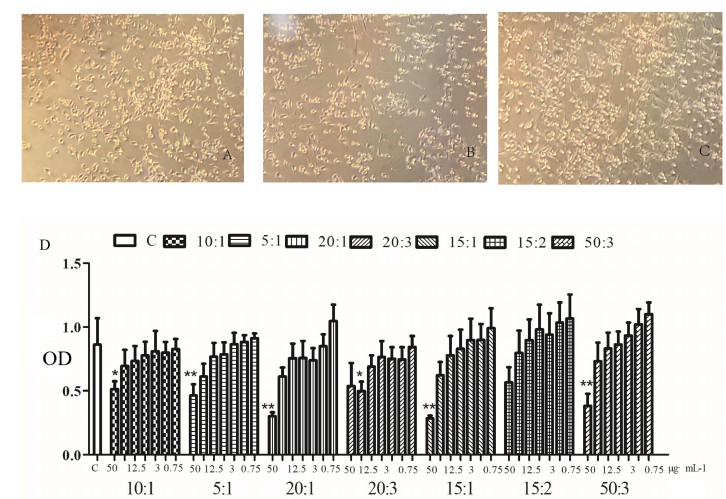
Figure 1. Cell morphology of Normal control group ( A ), Model group ( B ) and Administration group with boswellic acid (BA): myrrha sesquiterpenes (MS) (10:1) drug ( C ) ( × 200). E ff ects of di ff erent ratios of boswellic acid (BA) and myrrha sesquiterpenes (MS) on cytotoxicity ( D ).